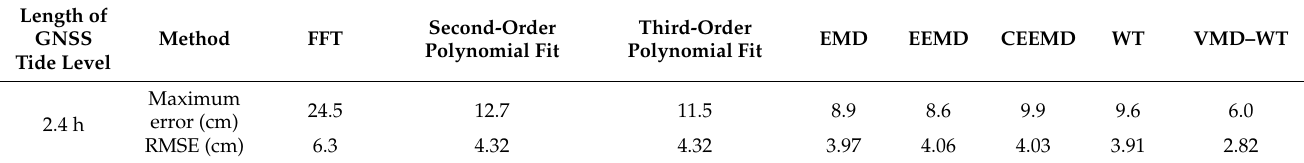
Table 5. Comparison of filtering effects of the eight methods for 2.4